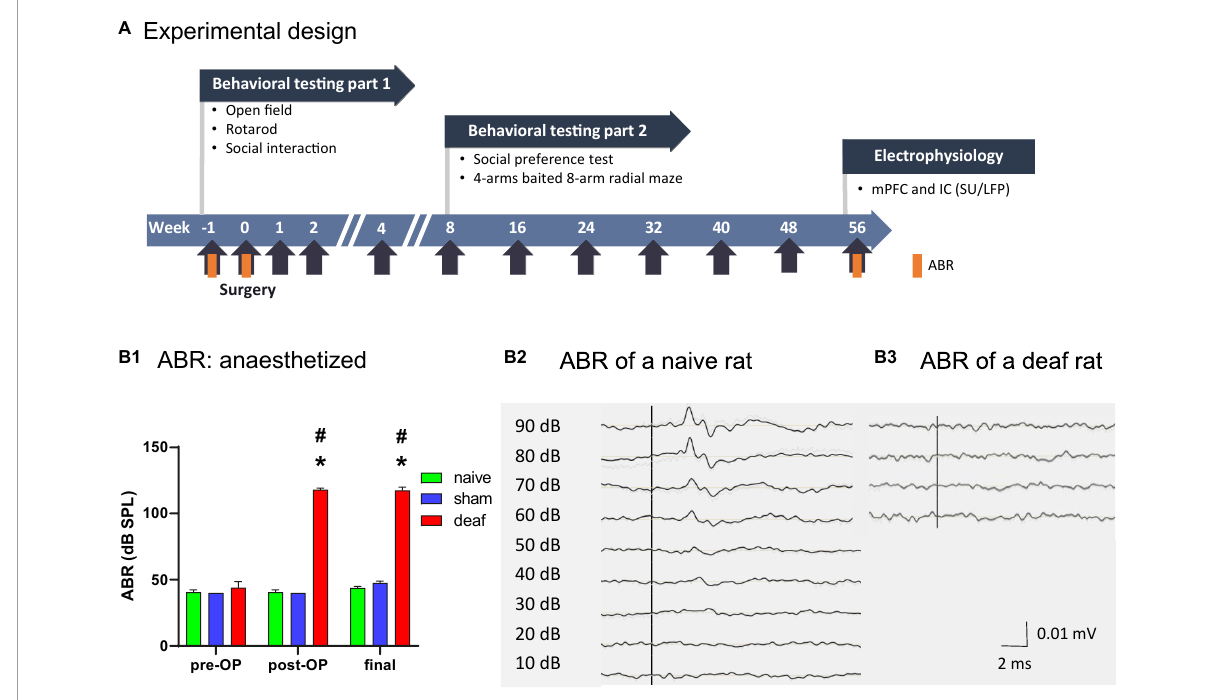
FIGURE1 Timeline of the experimental design (A) . Effects of the deafening surgery to the auditory brainstem response of naïve, sham, and deaf rats with data shown as means ± SEM pre OP, post OP, and at final measurements 56 weeks after surgery. Differences between deaf rats and sham or naïve controls are shown as asterisks (*) and to pre-OP values as rhombus ( # P < 0.05 after ANOVA; B1 ). Representative examples of ABRs of a naive (B2) and of a deaf rat (B3) are shown. ABR, auditory brainstem response. IC, inferior colliculus; LFP, local field potential; mPFC, medial prefrontal cortex; SU, single